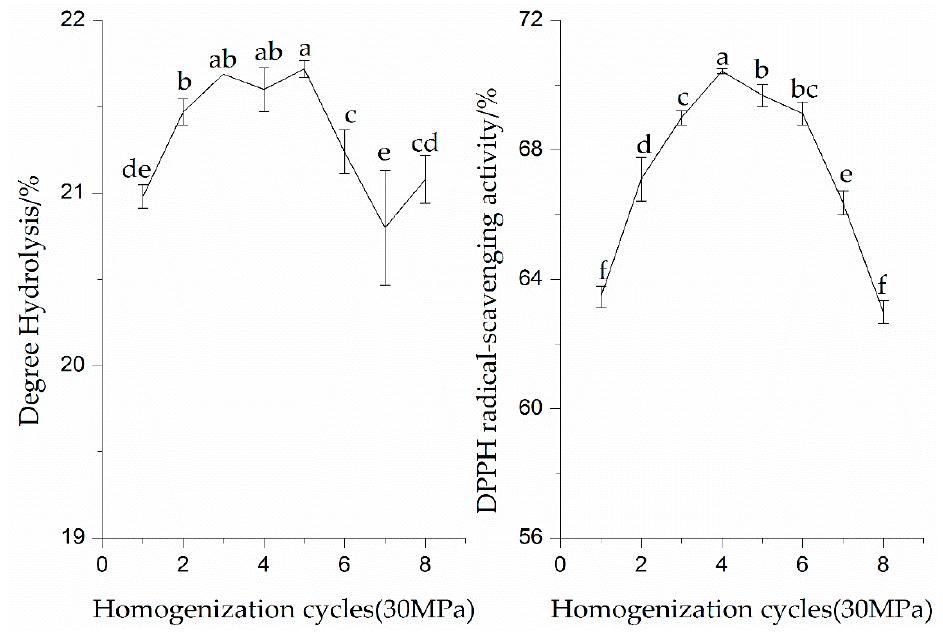
Figure 3. Effect of homogenization (30 MPa) cycles on enzymatic hydrolysis and DPPH radical-scavenging activity of the SPI hydrolysates. Values with different letters in the same column are significantly different according to Duncan’s multiple range test ( p < 0.05).